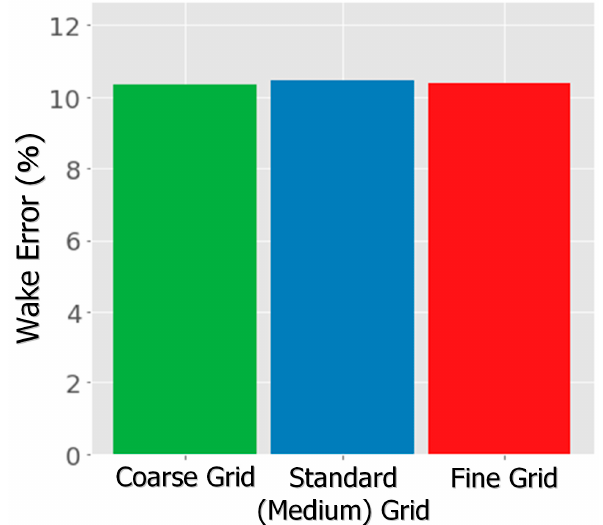
Figure 12. Comparison of wake error rate of time-averaged U-velocity in measurement line (x = 0.5D) shown by dotted line in Figure 9a.